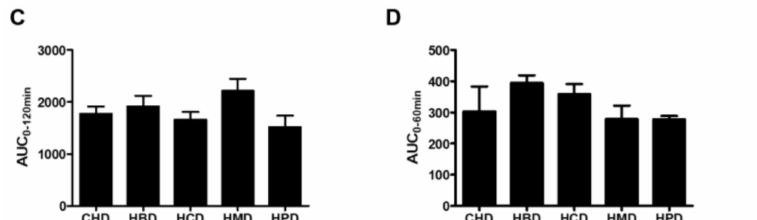
Figure 2. Blood glucose responses to intraperitoneal glucose tolerance (IPGTT) and insulin tolerance (IPITT) tests. ( A ) Blood glucose concentrations for IPGTT and ( B ) blood glucose concentrations for IPITT. Each dot represents the mean value from four to five animals; ( C , D ) Area under the curves (AUC) for blood glucose during IPGTT and IPITT, respectively. Data are presented as mean ± standard deviation, n = 4–5.